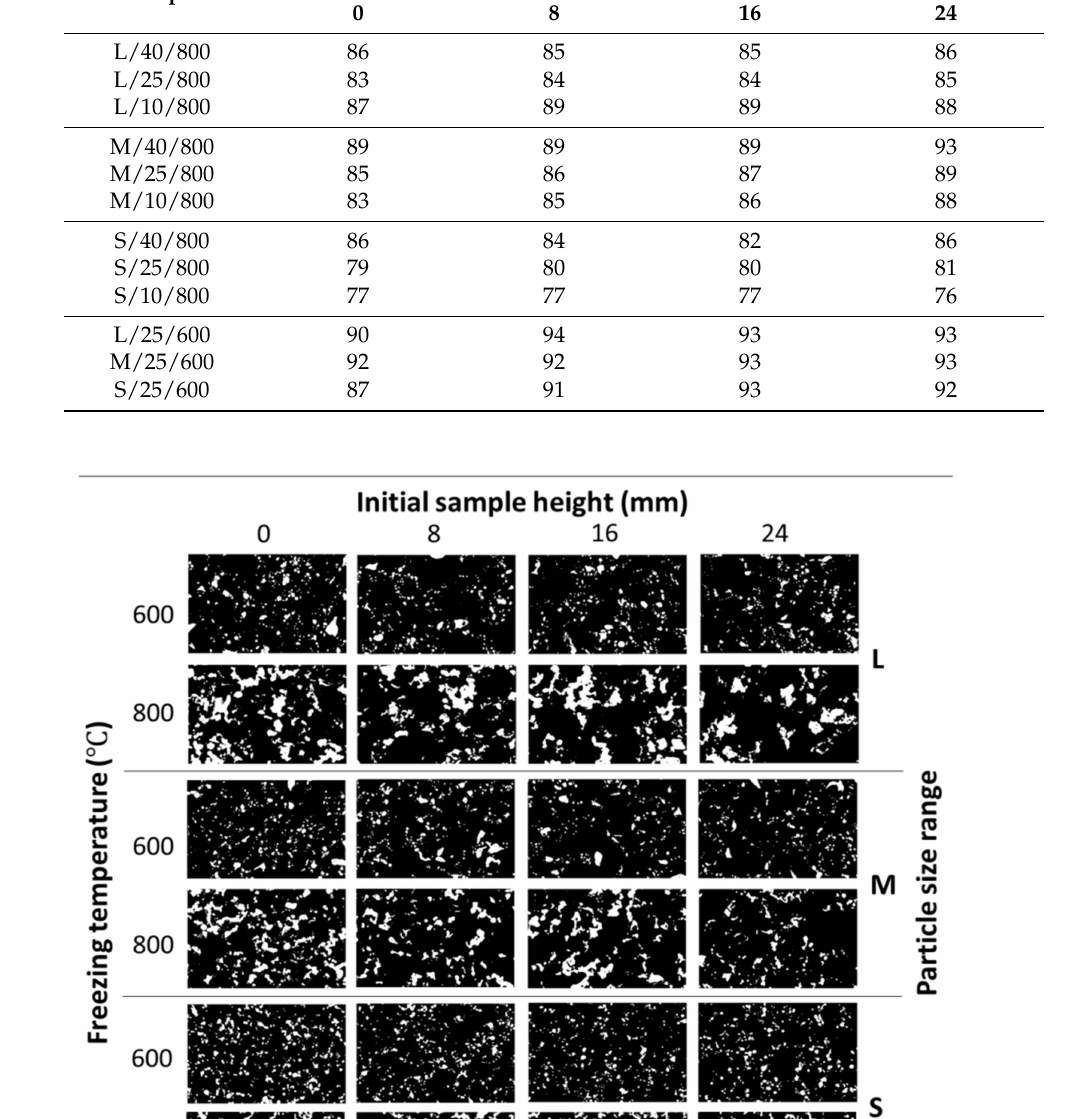
Table 2. Total porosity ( P T ) of the sintered Ni wicks across the initial sample height. Sample